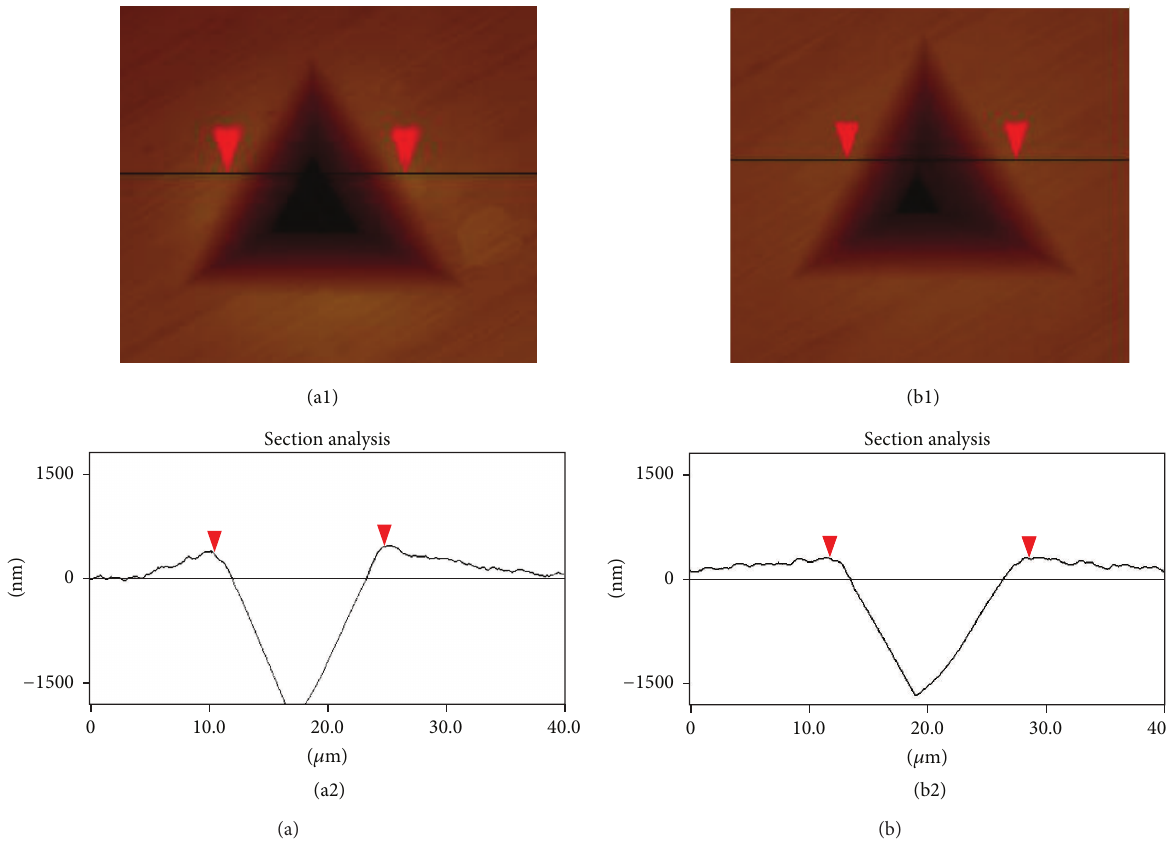
Figure 13: Appearance of the indentation geometry by AFM at the center (a) and edge (b) of the HPTed niobium disk. It can be observed that, at the center of the disk, significant pileup effect is present (a2), while, at the edge, neither sink-in nor pileup effect is observed (b2)